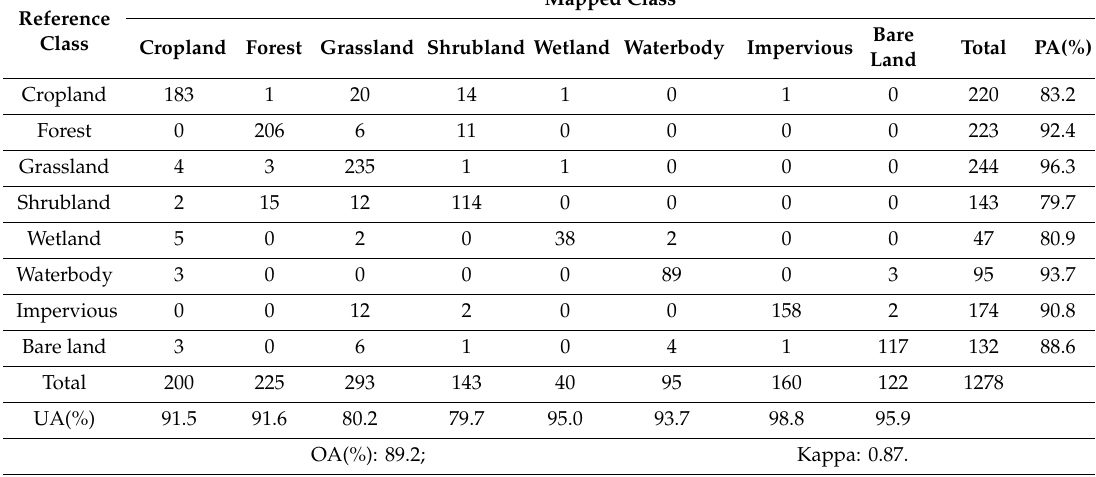
Table 2. Accuracy assessment of the MDG LC-10 map’s confusion matrix based on the independent validation